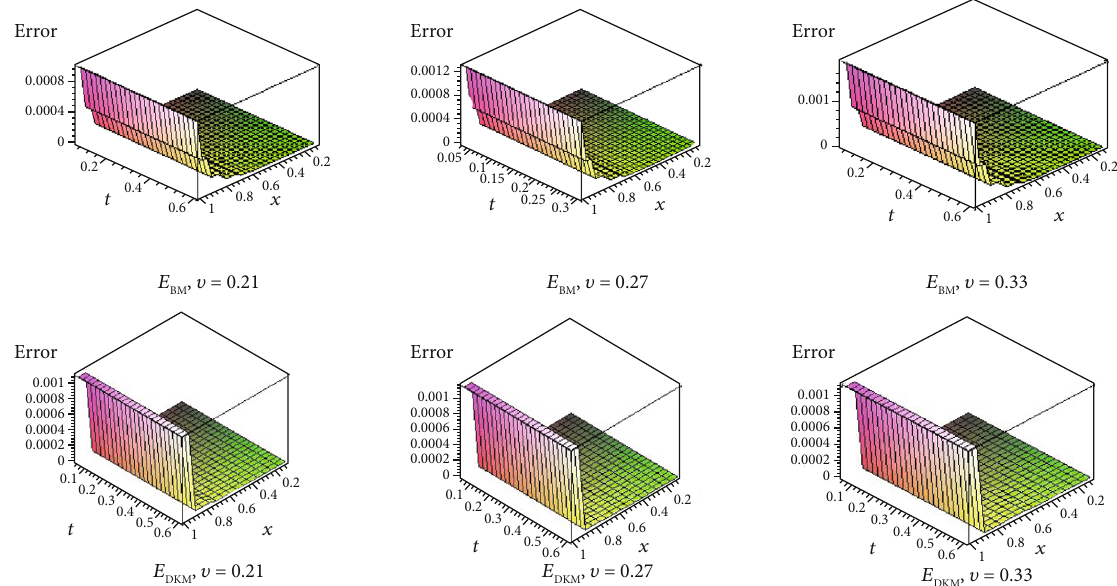
Figure 8: The values of errors by B-by-BM and DKM at T = 0 : 6 , N = 10 , and k = 2 for υ = 0 : 21, 0 : 27, 0 : 33